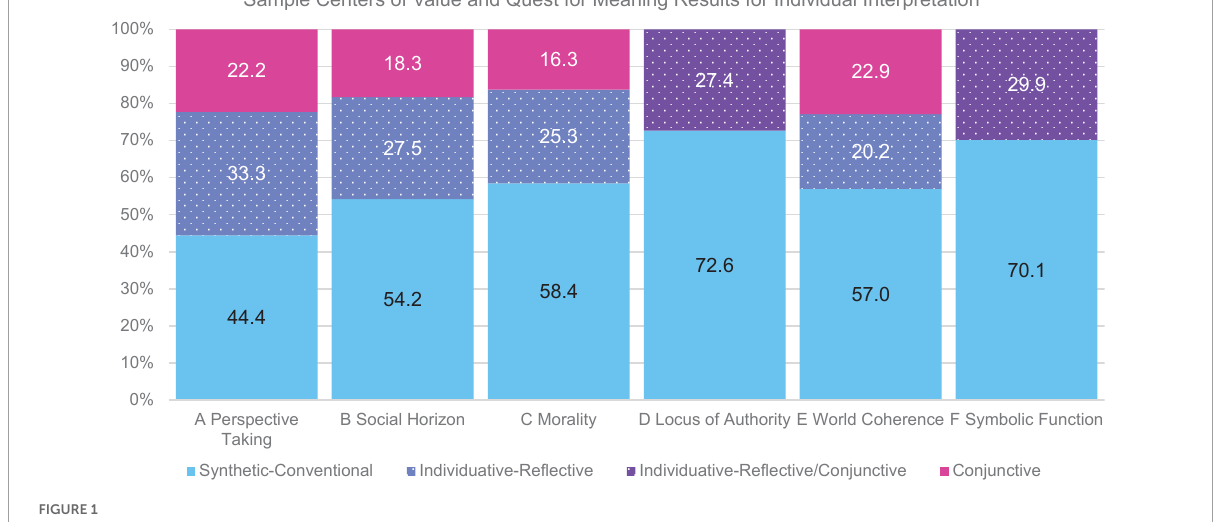
FIGURE1 Sample stacked bar chart of simplified presentation of stages/styles by aspect for individual case